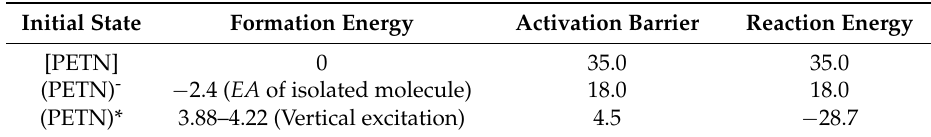
Table 1. The decomposition of PETN in its equilibrium, [PETN], charged, (PETN) - , and excited, (PETN)*, states is illustrated by the corresponding energy of the initial state formation (in eV), activation barrier for the O-NO 2 homolysis reaction (in kcal/mol), and the reaction energy (in kcal/mol). Initial State Formation Energy Activation Barrier Reaction Energy [PETN] 0